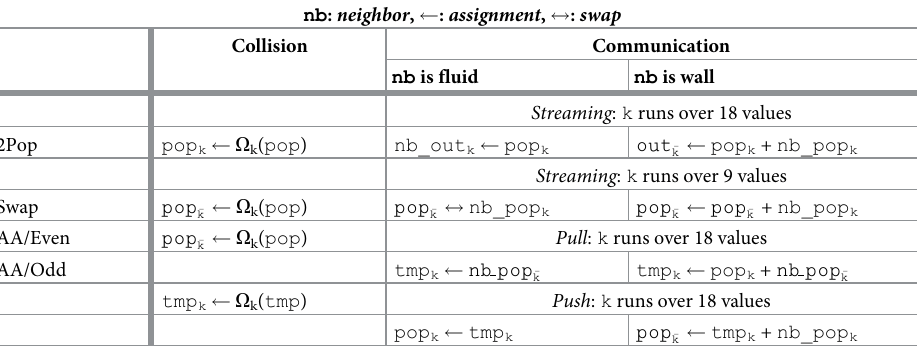
Table 1. The algorithms executed for the three implemented